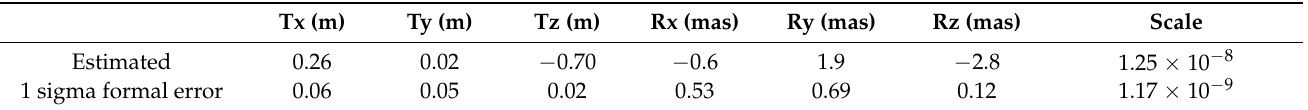
Table 4. Helmert parameters relating the origin, orientation and scale of the Broadcast reference frame of C12 relative to the IGS14 frame of the SP3 precise ephemeris for SV C12, 2 January 2020. The scale factor accounts for the Center of Mass–Antenna Phase Center correction in the radial direction.